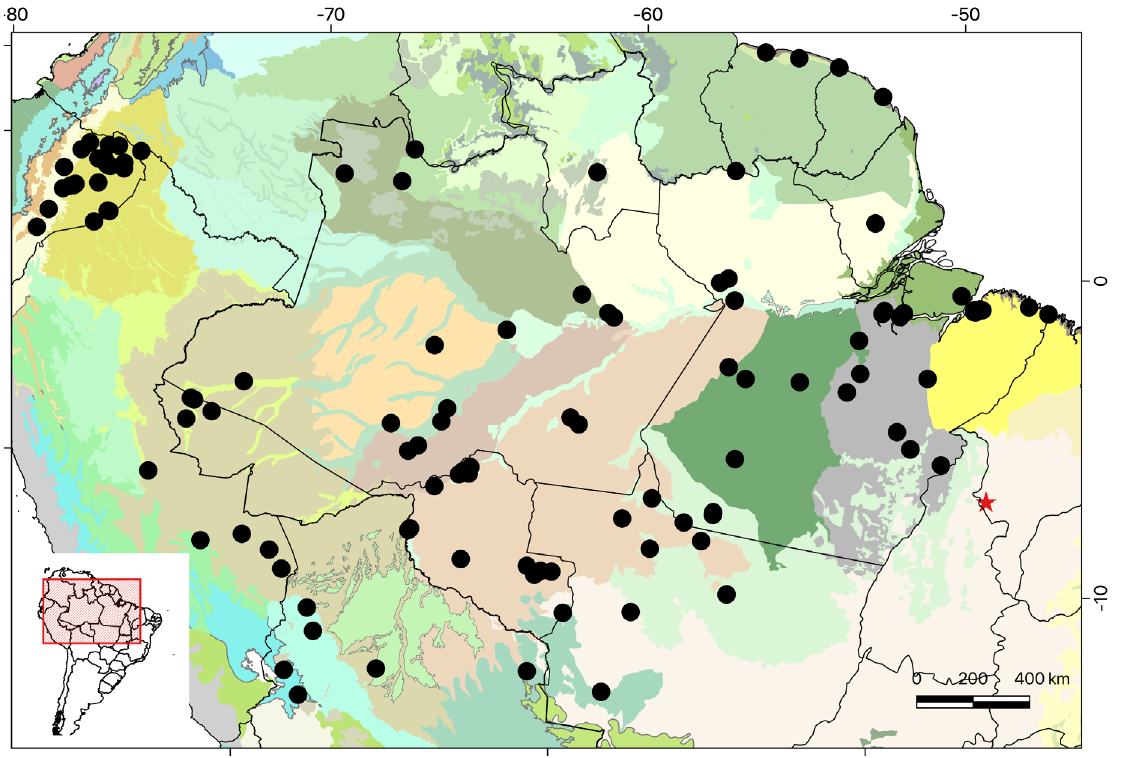
Figure 3. Distribution of Drepanoides anomalus in Brazil (MPEG 24157). Symbols: black circles: literature records; black question mark: literature records but with identification of the species not confirmed; red star: new record in Municipality of Carolina, Estreito Hydro- electric Plant, state of Maranhão (MPEG 21523). Ecoregions with point occurrence according to Dinerstein et al. (2017): Tocantins- Pindaré moist Forest;